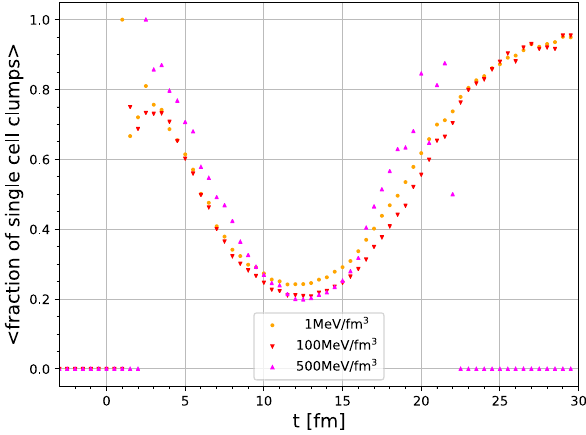
Fig. 21 Time evolution of the average compactness of the connected regions (clumps) satisfying the constraints X ebe < 0 . 3 and Y ebe < 0 . 3 for the energy density thresholds ε > 100 MeV / fm 3 or 500 MeV / fm 3 , in Au+Au collisions at E lab = 1.23 AGeV, 0–5% centrality class